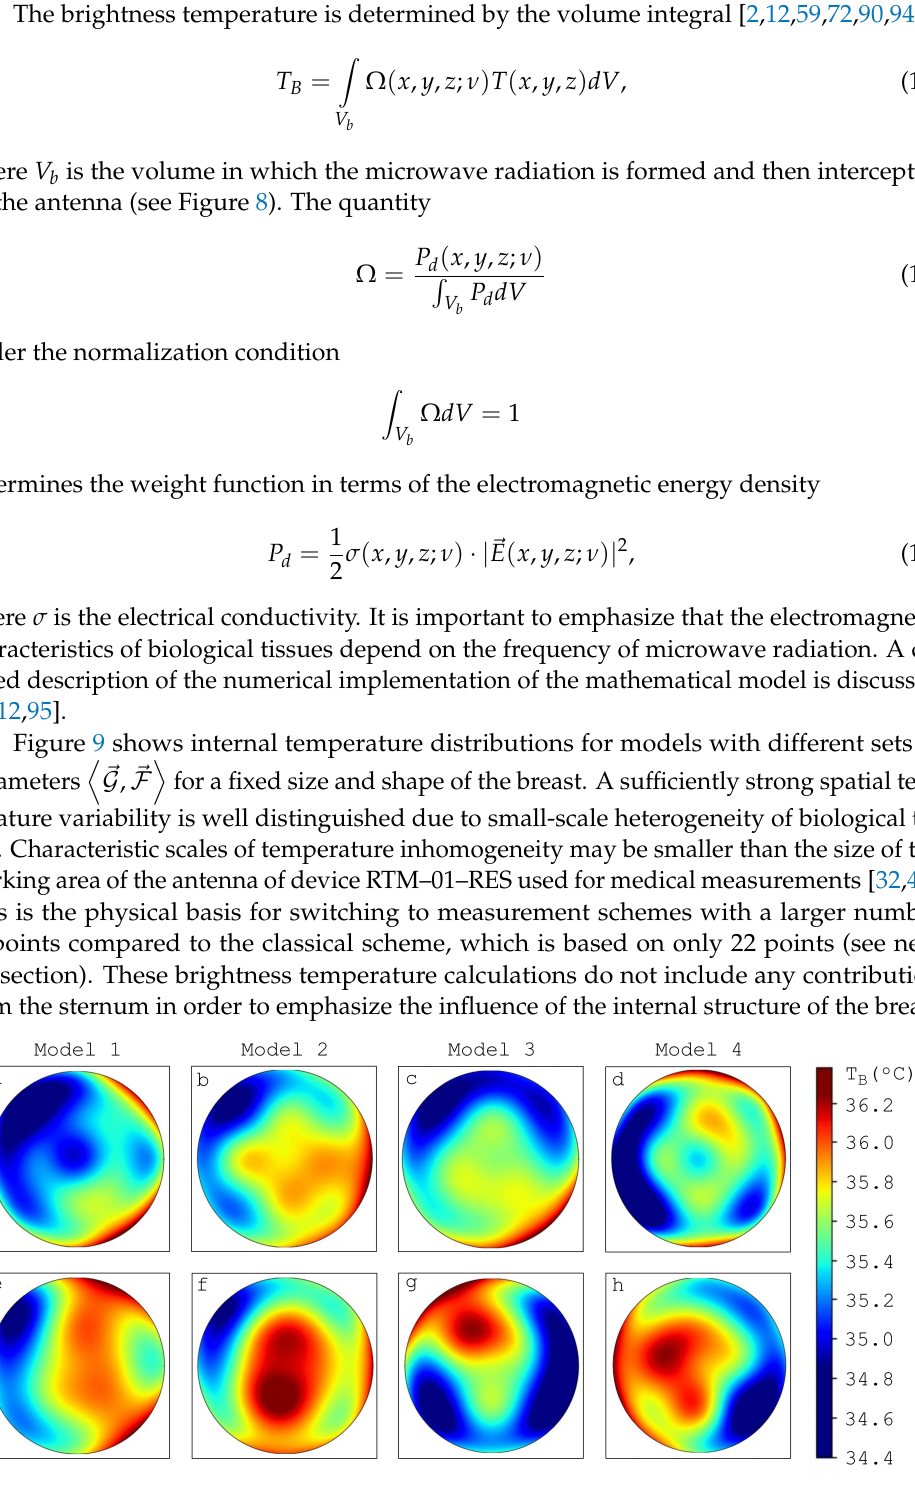
Figure 9. Brightness temperature distributions based on the results of simulations using a modified measurement scheme for four models (1— a , e ; 2— b , f ; 3— c , g ; 4— d , h ): top row—without tumor, bottom row—with tumor. Tumor parameters: Q ( can ) = 35,400 W · m − 3 , R = 1